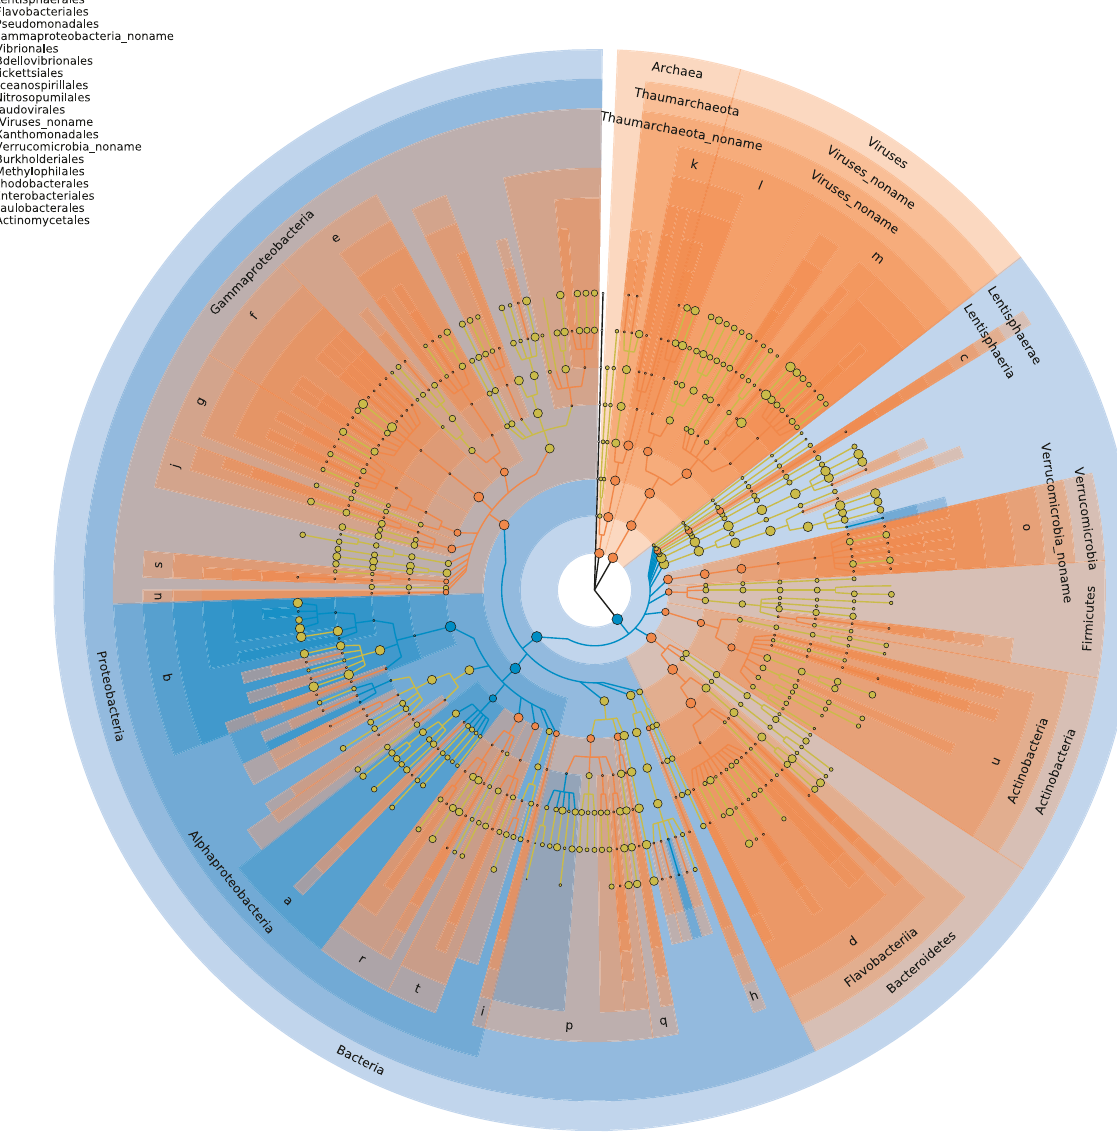
Fig. 3 Cladogram showing the taxonomic position of the unassembled (orange) and assembled (blue) fractions and their relative abundance. Each circle diameter is proportional to the taxon ’ s abundance, and the color represents which branch of the phylogenetic tree is more abundant in each fraction.